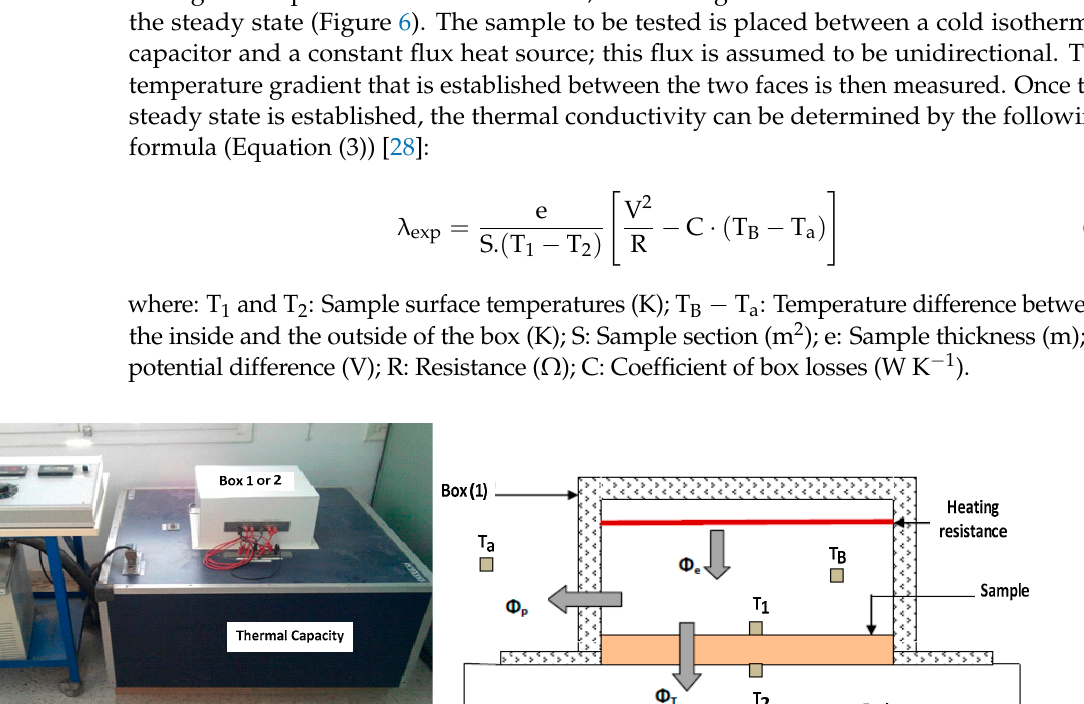
Figure 7. Compressive strength test. 2.3.6. Ultrasonic Pulse Velocity Test